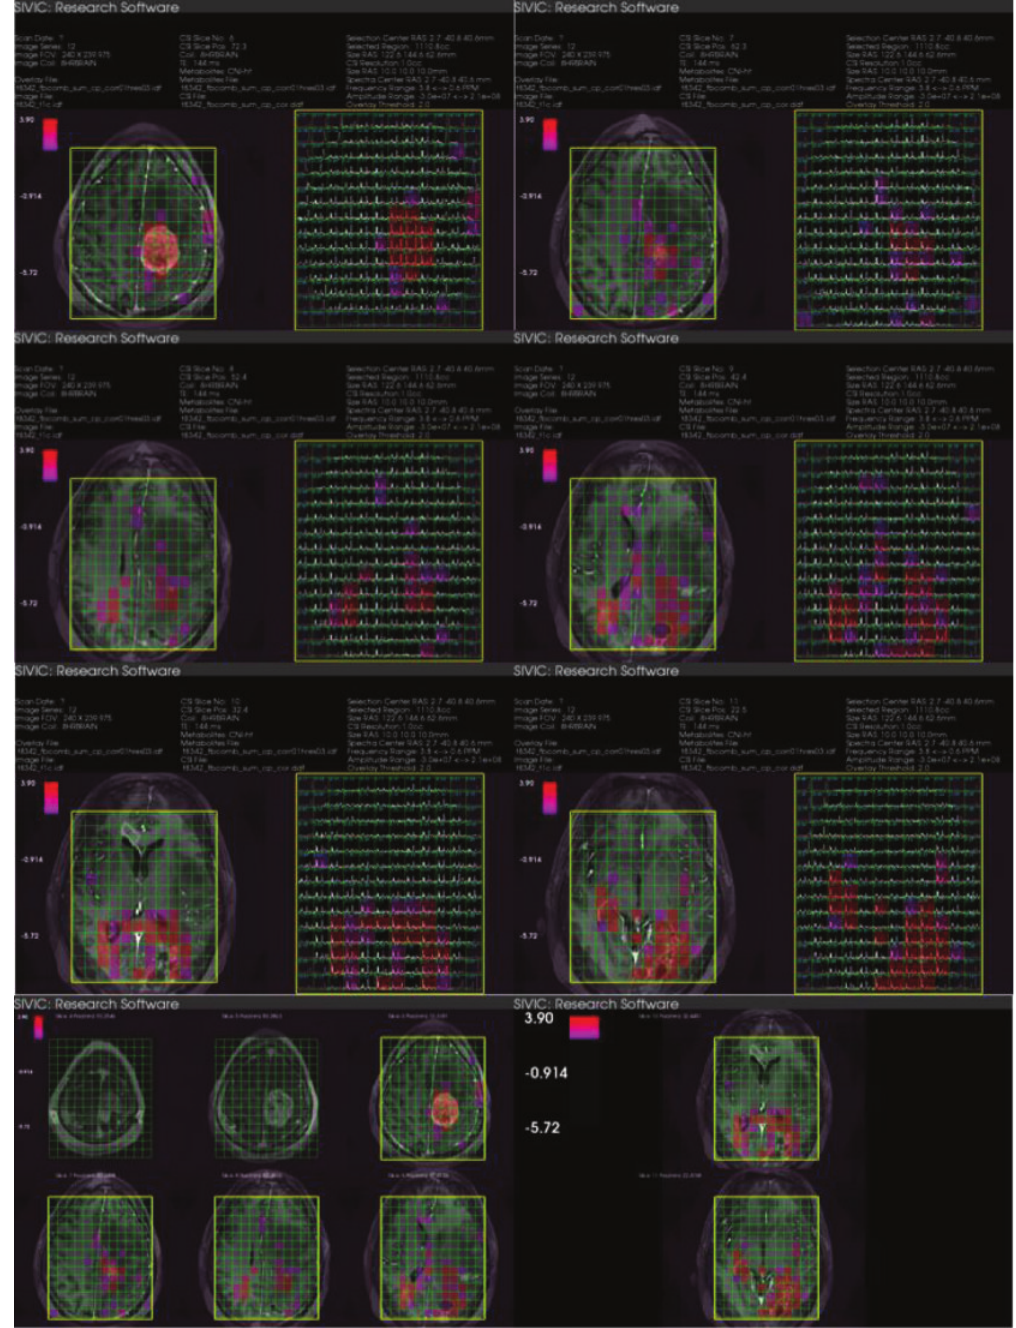
Figure 11: SIVIC generated DICOM secondary capture report for UCSF MRS exam. The series consists of 8 images shown here. The color overlay represents the choline to NAA index. Spatial referencing to T1 postcontrast image, volume localization (yellow), and sat bands (purple shading) are shown. The final two images are summary representations of the acquisition referenced to the anatomical